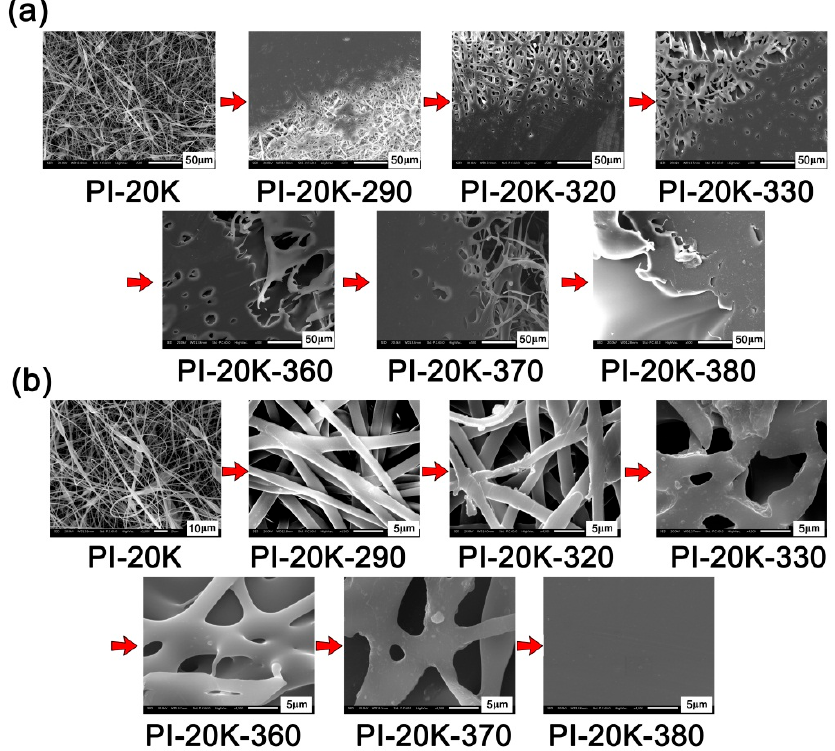
Figure 11. SEM images of electrospun PETI ‐ 20K nano ‐ fibrous membranes at elevated tempera ‐ tures. ( a ) ×500; ( b ) ×4500. ( a ) × 500; ( b ) ×